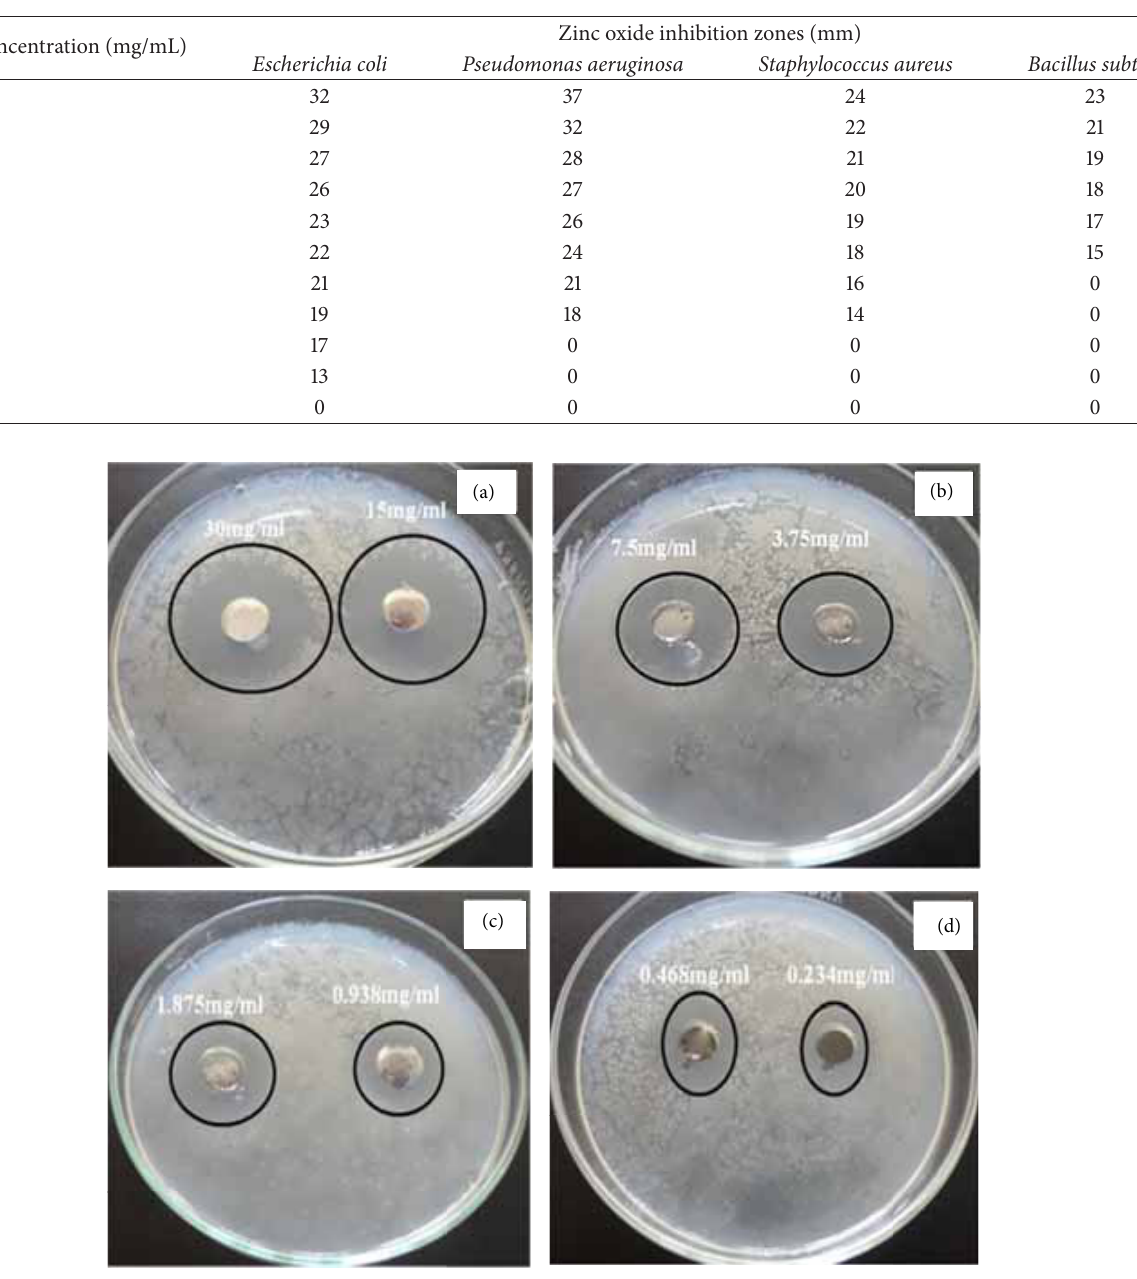
Figure 18: The antimicrobial activity of zinc oxide nanotubes against Pseudomonas aeruginosa using disc diffusion method. ((a), (b), (c), and (d)) Different concentrations of the synthesized